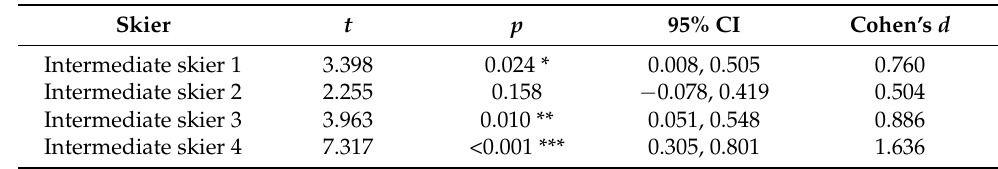
Table 2. Results of the post-hoc comparisons for the quantitative waist rotation feature. The expert skier was compared to each intermediate skier.